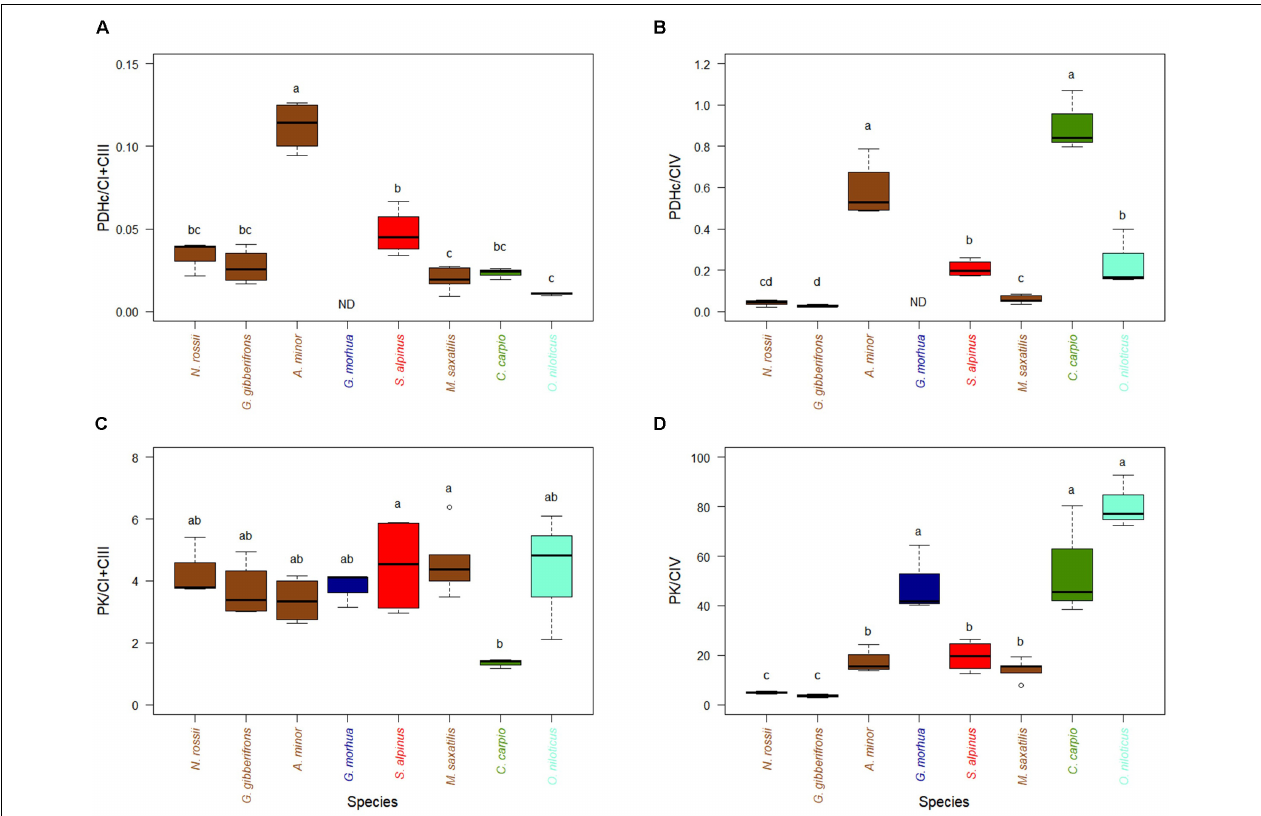
FIGURE 1 | Activity of mitochondrial substrate entrance enzymes of pyruvate pathway (PDHc and PK) in hearts of cold-adapted fish (left), cold-temperate adapted fish, and warm-adapted fish (right). Activities were measured at temperature near their thermal optimum. (A) Pyruvate dehydrogenase complex (PDHc) expressed relative to CI + CIII activity. (B) PDHc expressed relative to CIV activity. (C) PK activity expressed relative to CI + CIII. (D) PK activity expressed relative to CIV. Values are represented as mean ± sem. Statistical differences are represented with letters ( p < 0.05). ND: no data. Notothenia rossii ( n = 3). Gobionotothen gibberifrons ( n = 4). Anarhichas minor ( n = 4). Gadus morhua ( n = 3). Salvelinus alpinus ( n = 4). Morone saxatilis ( n = 5). Cyprinus carpio ( n = 3). Oreochromis niloticus ( n = 3). Brown boxes represent Perciformes, dark blue Gadiforme, red Salmoniforme, green Cypriniformes, and light blue is